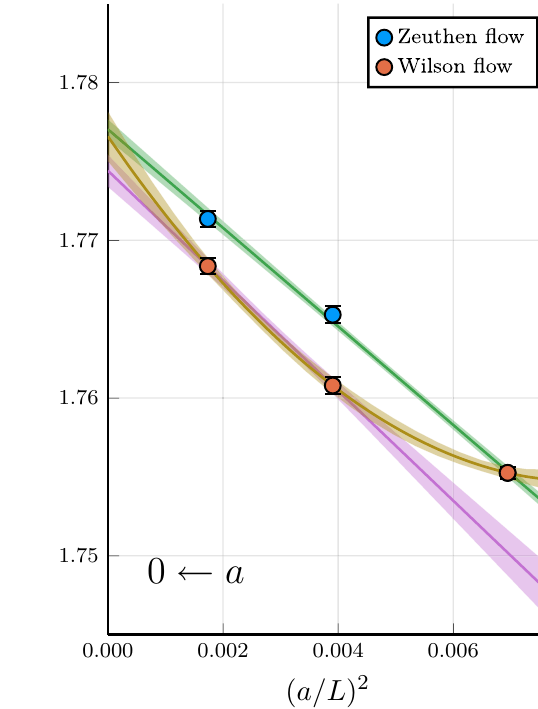
0 . 0000 . 0020 . 0040 .